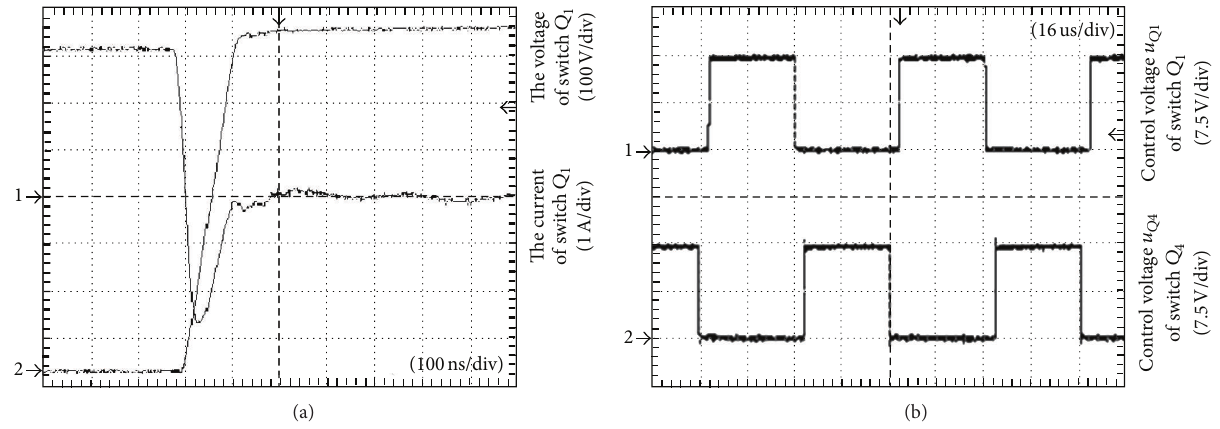
Figure 9: The waveforms of switching process and control voltages: (a) the switching process of switch 𝑄 1 , (b) the control voltages for the switch 𝑄 1 and 𝑄 4 . The voltage measured in CH2 by the voltage transformer; the proportion is 1V = 100V; in CH1, 1V = 1A; the time per DIV is 100ns. In CH1, the voltage per DIV is 7.5V; in CH2, the voltage per DIV is 7.5V; the time per DIV is